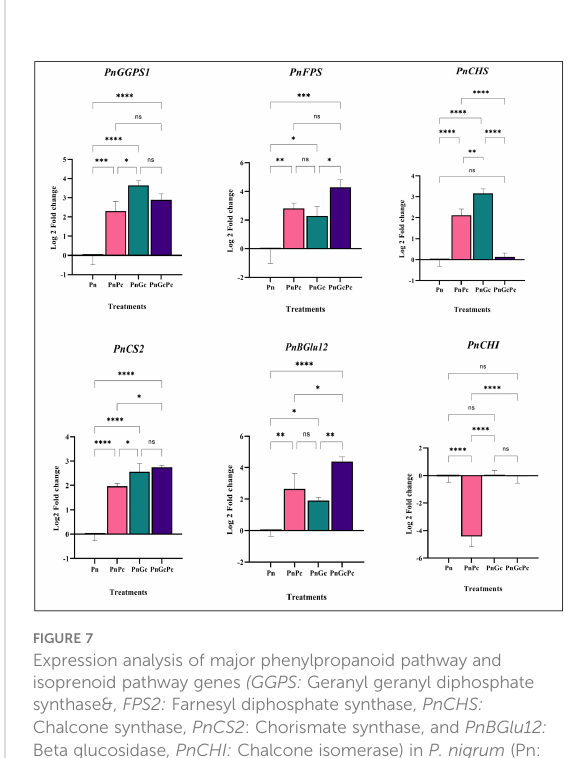
FIGURE 7 Expression analysis of major phenylpropanoid pathway and isoprenoid pathway genes (GGPS: Geranyl geranyl diphosphate synthase&, FPS2: Farnesyl diphosphate synthase, PnCHS: Chalcone synthase, PnCS2 : Chorismate synthase, and PnBGlu12: Beta glucosidase, PnCHI: Chalcone isomerase) in P. nigrum (Pn: P. nigrum control, PnPc: P. nigrum infected with P. capsici 24hpi, PnGC: P. nigrum in fi ltrated with GC 24h, PnGcPc: P. nigrum infected with P. capsici 24h post in fi ltration with Glycol chitosan, 24hpi. Comparative gene expression was calculated according to the 2 − DD C T method (Schmittgen and Livak, 2008). One-way ANOVA was performed to compare among treatments. Values are means of triplicates. Data are expressed as Mean ± SEM. p ≤ 0.05, 0.01, 0.001, 0.0001 are represented by *, **, ***, **** respectively and p ≥ 0.05 is represented by ns (not signi fi